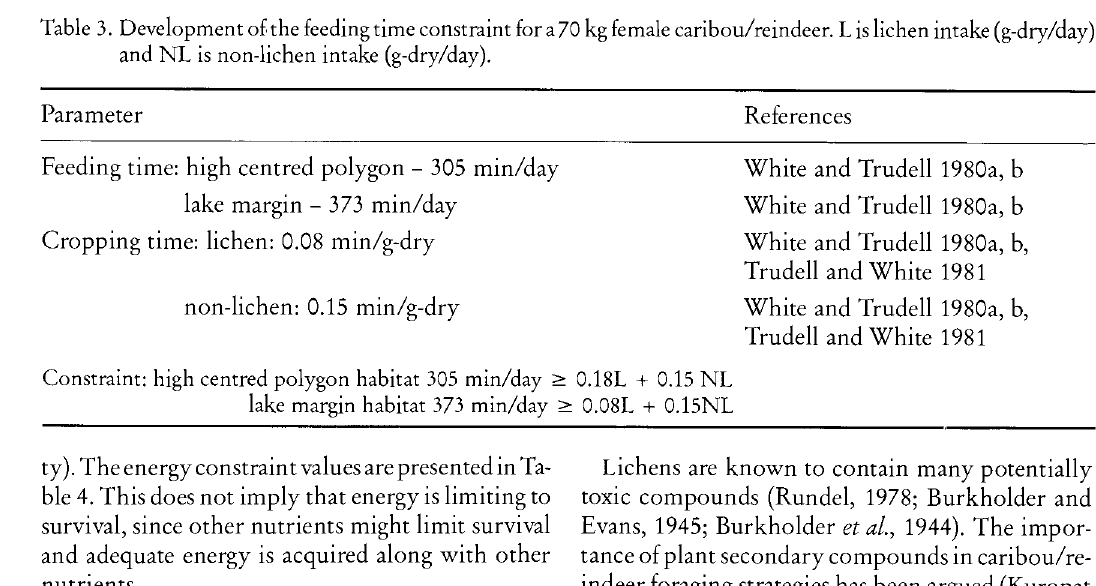
Table 3. Development of the feeding time constraint for a 70 kg female caribou/reindeer. L is lichen intake (g-dry/day) and NL is non-lichen intake